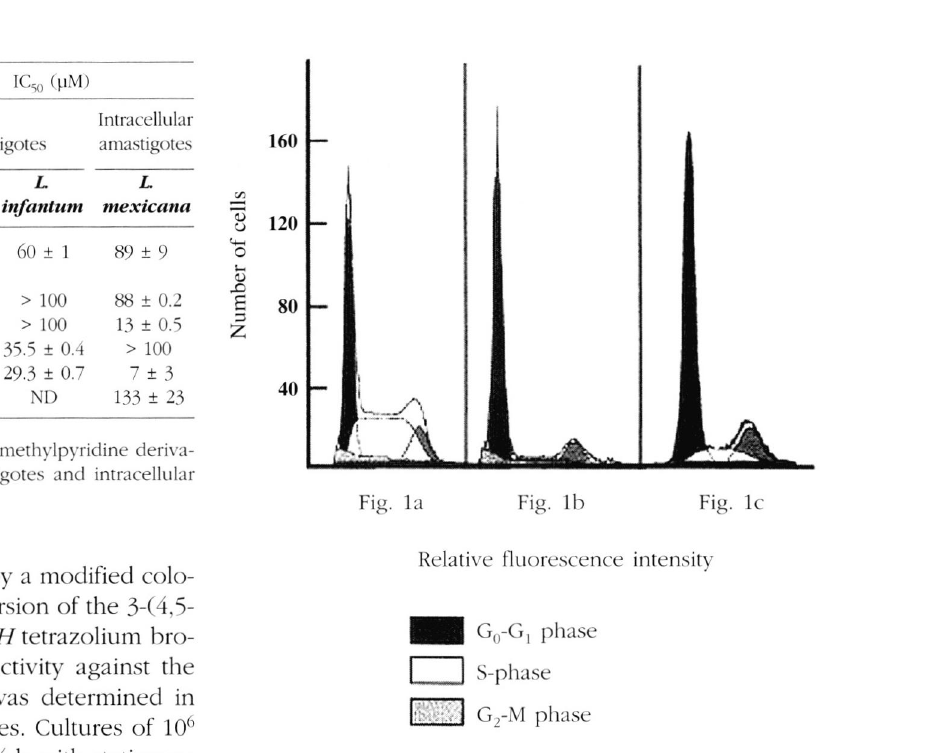
Fijj;. 1. - Example of histograms of DNA fluorescence corresponding to the distribution of the cells in different phases of the cell cycle in the control culture (la) and in culture treated with pentamidine (lb) or furan-2-carboxamide (I) (lc). after a 28 hours incubation period. Ten thousands cells were acquired for each